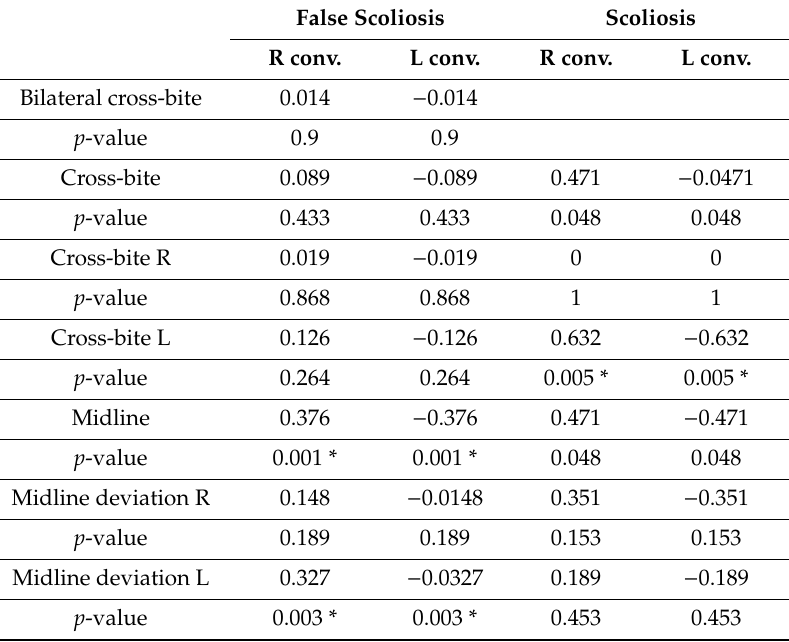
Table 7. Values of r Pearson correlation for cross-bite and midline deviation related to groups of false scoliosis and scoliosis subjects. *: p < 0.05, statistically significant.